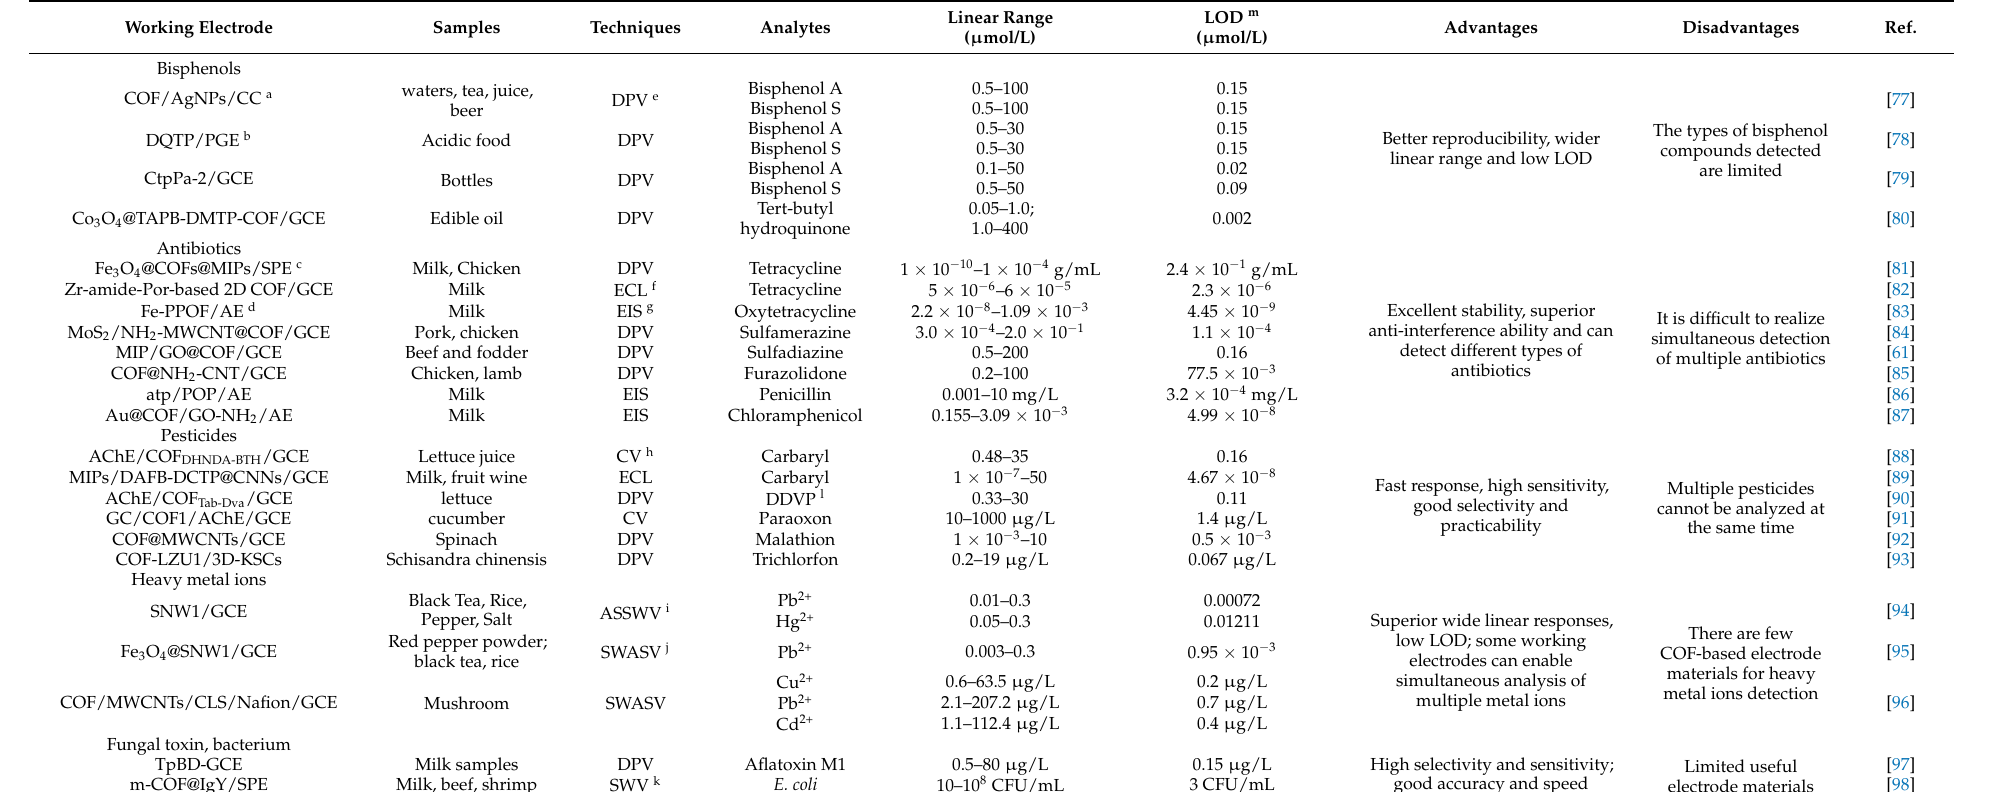
Table 3. COF-based sensors for food safety